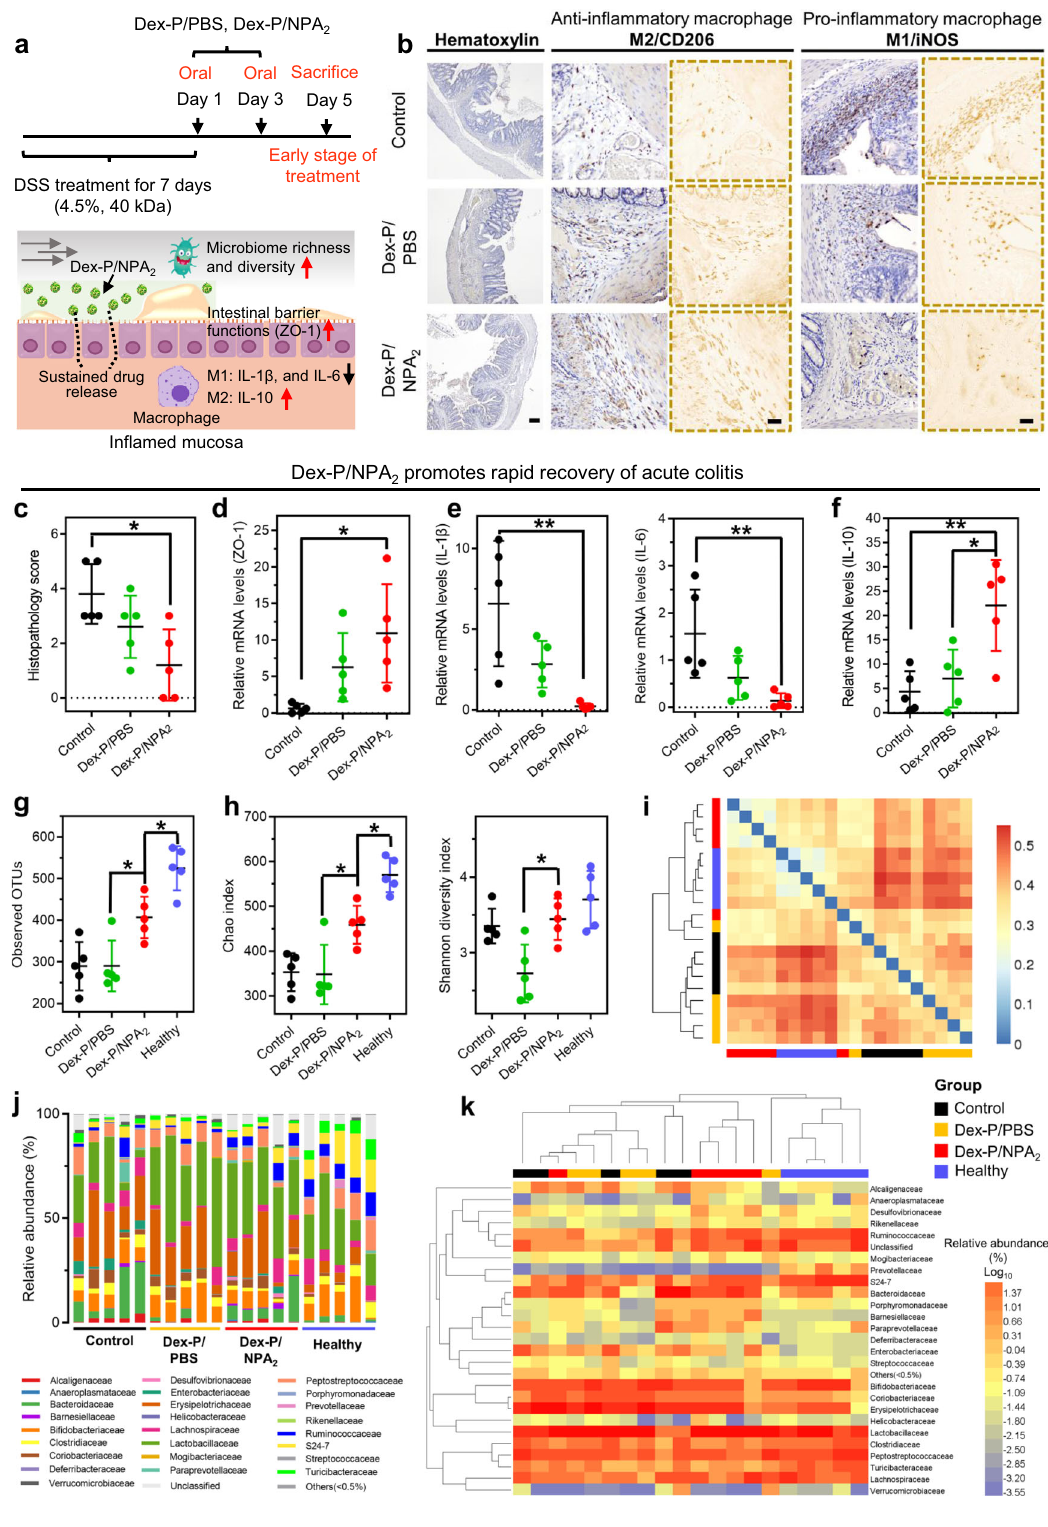
and diversity (Chao and Shannon indices) in colitic SD rats (Fig. 5g, h). In addition, a heatmap of β -diversity distance distribution was generated, and samples with similar β -diversity were clustered to re fl ect the similar compositions of gut microbiota (Fig. 5i). The β -diversities between colitic SD rats receiving Dex-P/NPA 2 and healthy SD rats were clustered more closely compared with colitic SD rats in the Dex-P/PBS group